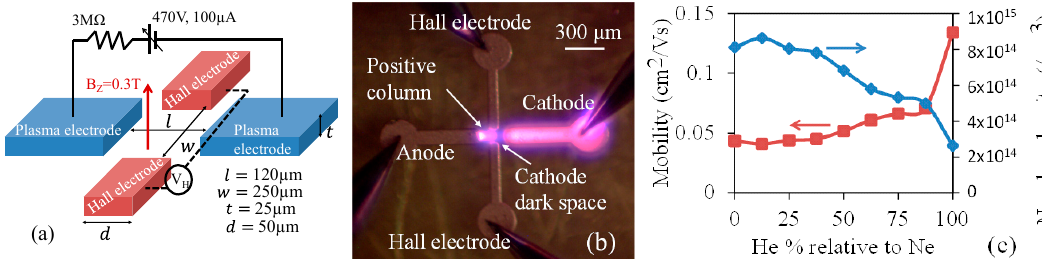
Figure 5. ( a ) Experimental setup for the Hall measurement. ( b ) Optical image of the Hall measurement electrodes during operation. The Hall electrodes are in contact with the positive column and the cathode dark space. ( c ) Estimates of ion mobility and density obtained from the measured Hall voltage for a mixture of He and Ne gas in different proportions. All figures are reproduced from [25].